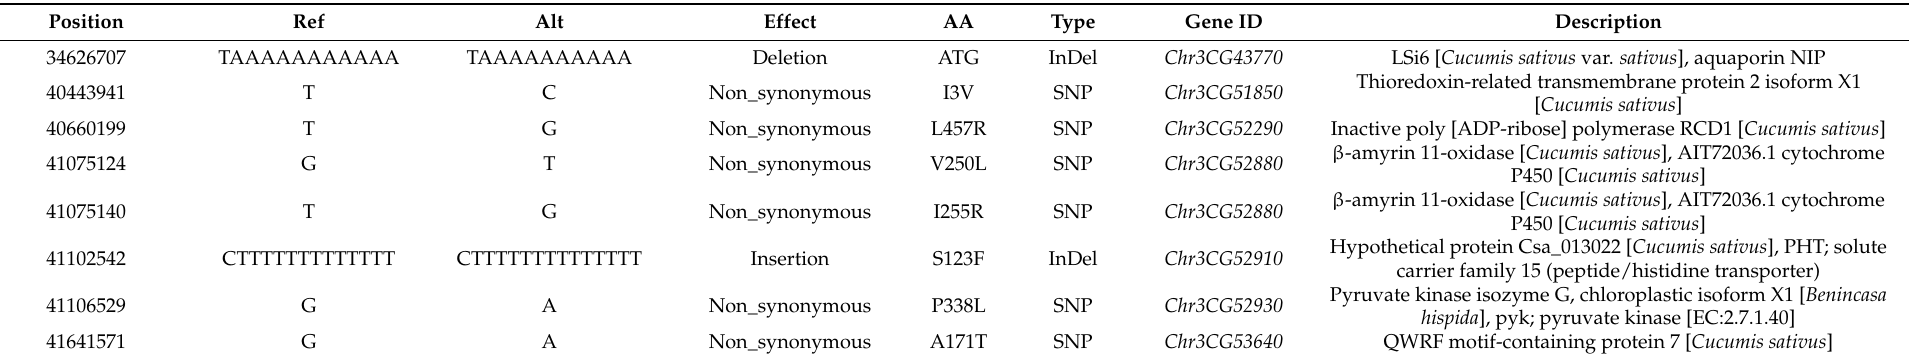
Table 5. Identification of sequence variations and candidate genes in the QTL region on chromosome 3.